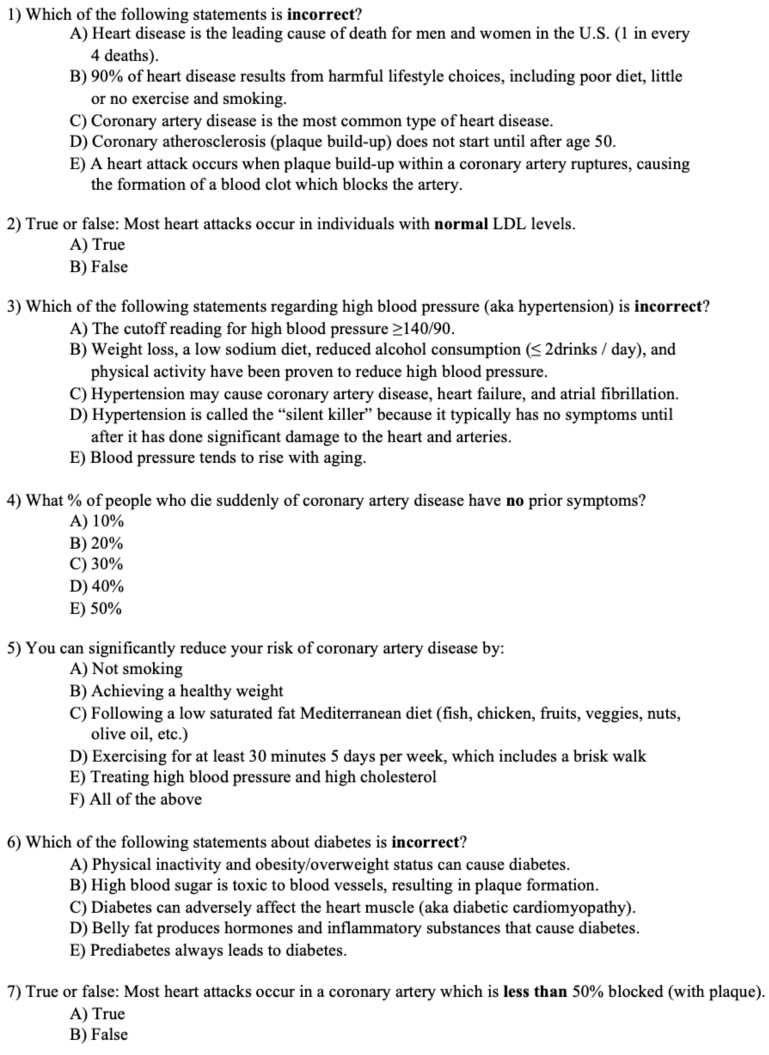
Fig. 4. Pre- and post-VR session cardiovascular health knowledge assessment.